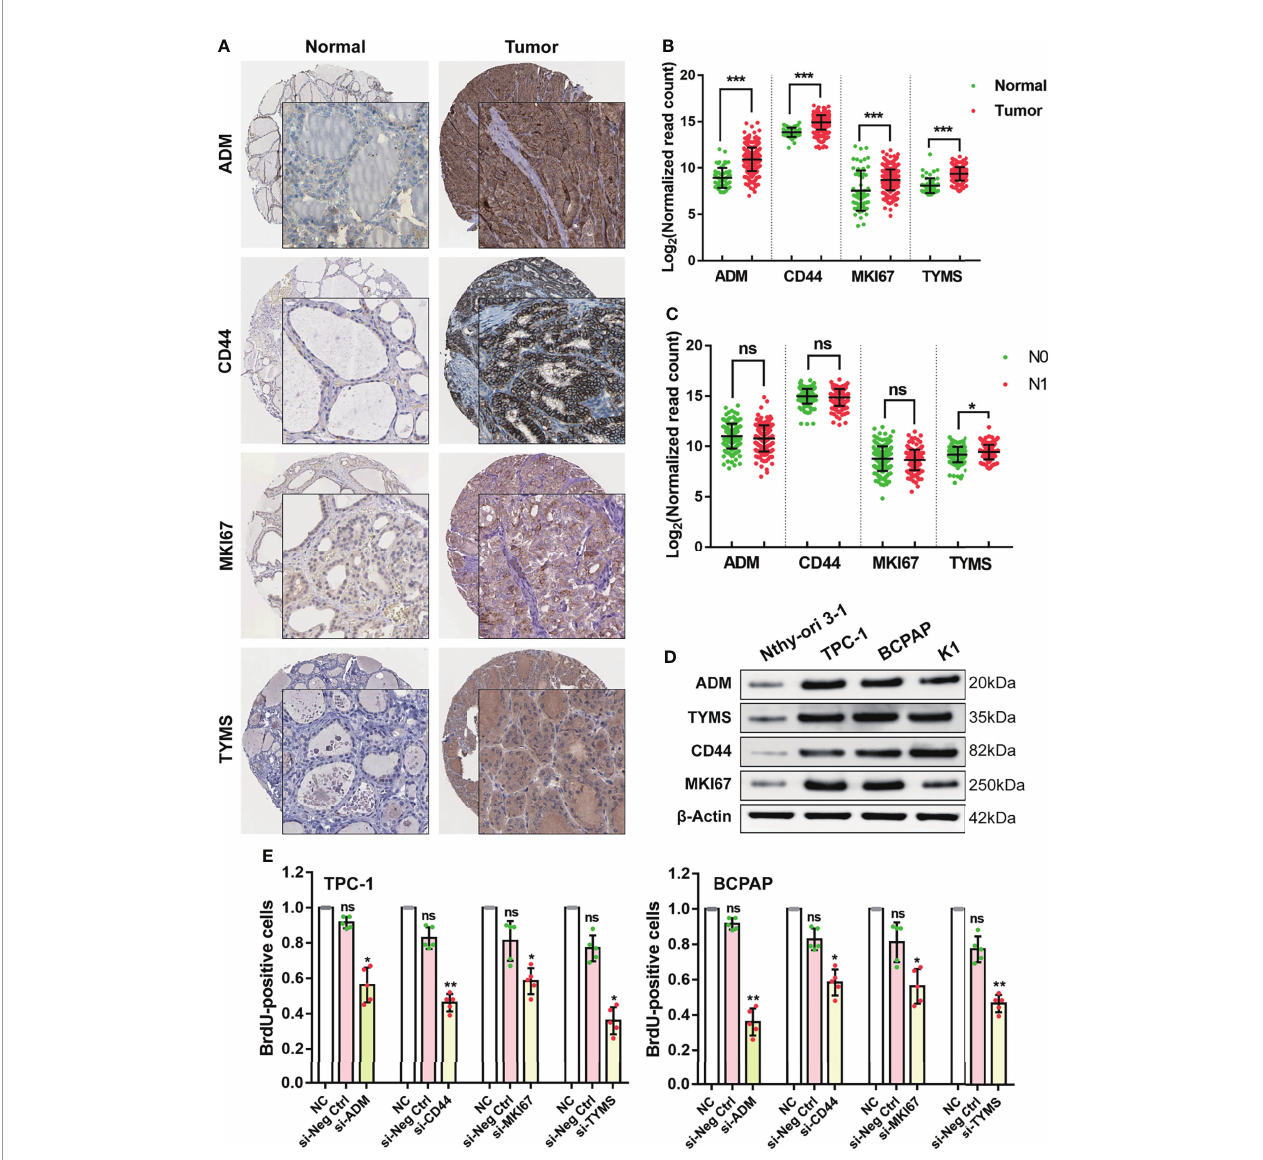
FIGURE 4 | Validating the function of the four GRGs in vivo and in vitro . (A) Protein expression levels of the four GRGs in DTC and normal tissues in The Human Protein Atlas database. (B) Comparison of the expression of the four GRGs between DTC and normal tissues. (C) Comparison of the expression of the four GRGs in tumors with lymph node metastasis (N1) and without lymph node metastasis (N0). (D) Western blot detection of the four GRGs in normal thyroid cells (Nthy-ori 3-1) and DTC cell lines (TPC-1, BCPAP, K1). (E) DTC cells (TPC-1, BCPAP) were transfected with blank plasmid or siRNA targeting the four GRGs, and cell proliferation was assessed using a BrdU cell proliferation assay kit. Signi fi cance was tested by t-test, *** p <0.001, ** p <0.01, * p <0.05, ns indicates no signi fi